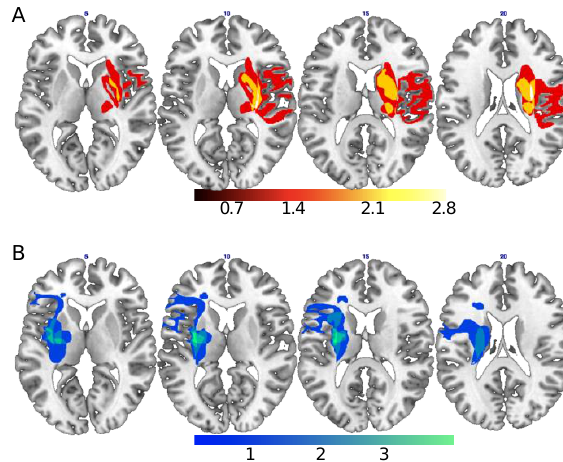
Figure 1. Regions of lesion overlap of RBDP ( A ) and LBDP ( B ). RBDP’ lesion overlap included precentral and postcentral gyri, superior and inferior frontal sulci/gyri, in the lateral and medial brain surfaces, supplementary motor area, insula, anterior and middle cingulate cortex, supramarginal gyrus, caudate nucleus, putamen, pallidum and thalamus, and superior temporal gyrus. LBDP’ lesion overlap included postcentral gyrus, superior and inferior frontal gyri/sulci, insula, hippocampus and parahippocampal cortex, amygdala, supramarginal gyrus, caudate nucleus, putamen, pallidum, thalamus, and superior temporal gyrus.